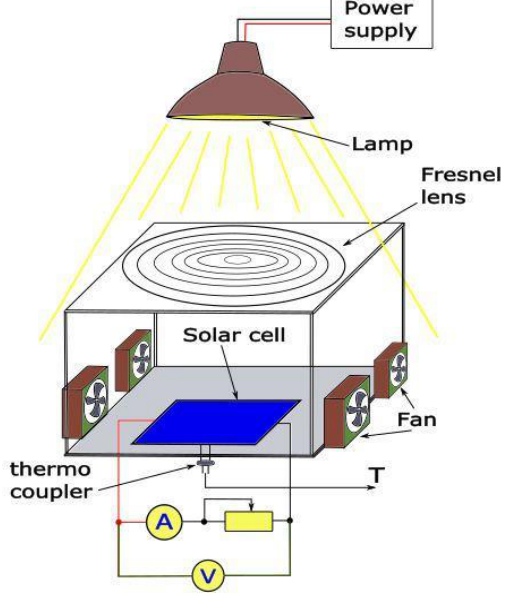
Figure 3. Diagram of the experimental setup for obtaining the light characteristics of a solar cell.